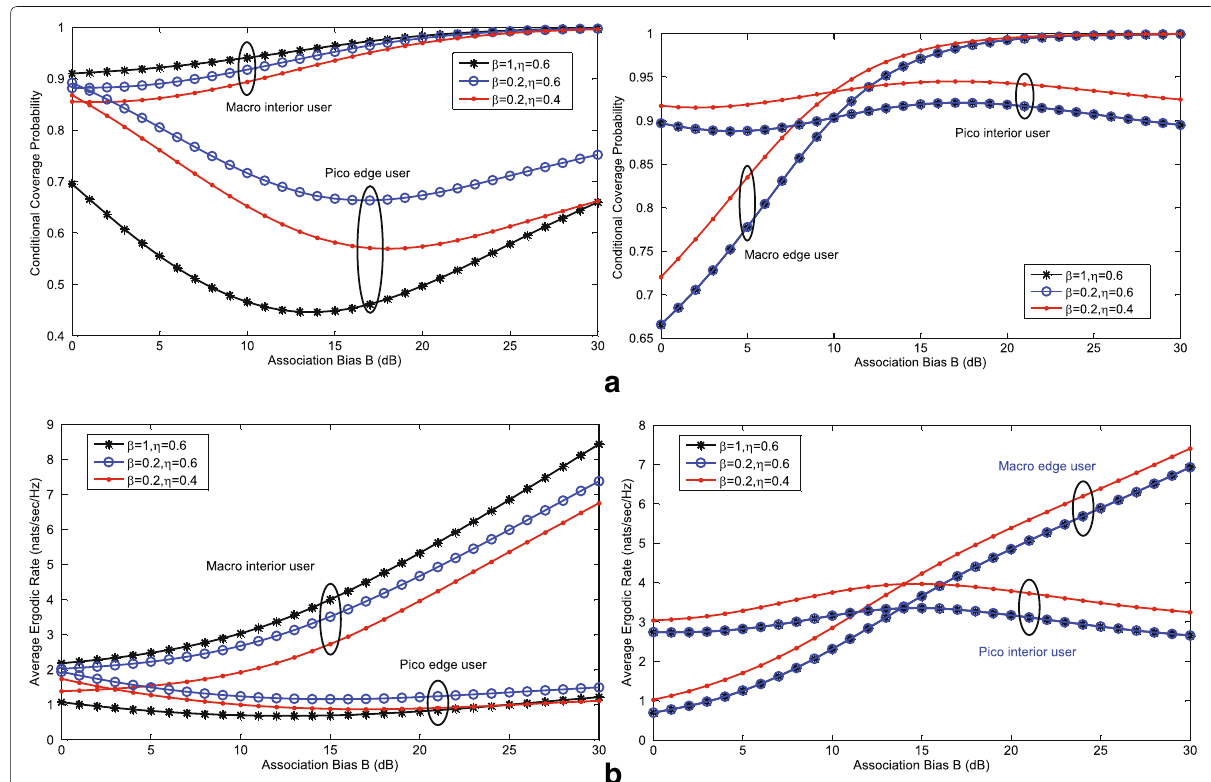
Fig. 6 Effect of power control factor and resource partitioning factor (β , η) on conditional coverage probabilities and average rate of four types of user with a T FR,1 = T FR,2 = 3 dB and T = 0.5 ( − 3 dB ) b T FR,1 = T FR,2 = 3 dB, as association bias is varied